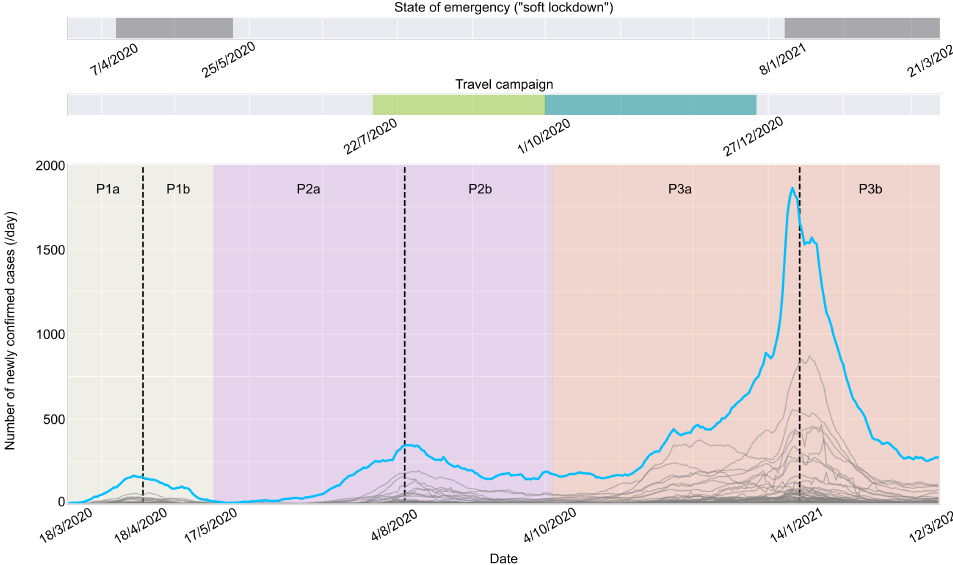
Figure 1. Timelineof the pandemic of coronavirus disease 2019 (COVID-19) in Japan. The period from 18 March 2020 to 12 March 2021 was considered. The top row indicates the period during which a state of emergency (i.e., “soft lockdown”, or mild restrictions on movement, alcohol-serving businesses, and large events) was declared. The second row indicates the period of a travel campaign, “Go To Travel”, during which the Japanese government encouraged the citizens to travel domestically by subsidizing travel expenses. The travel campaign had two stages: (1) the first from 22 July 2020 to 30 September 2020, during which Tokyo was excluded from the campaign, and (2) the second from 1 October 2020 to 27 December 2020, during which Tokyo was included and the subsidy was increased from stage 1. The main panel exhibits the 7-day backward moving average of the number of newly confirmed cases in each prefecture, which are highlighted in blue for Tokyo. Depending on the phase of the pandemic, the period was divided into six different